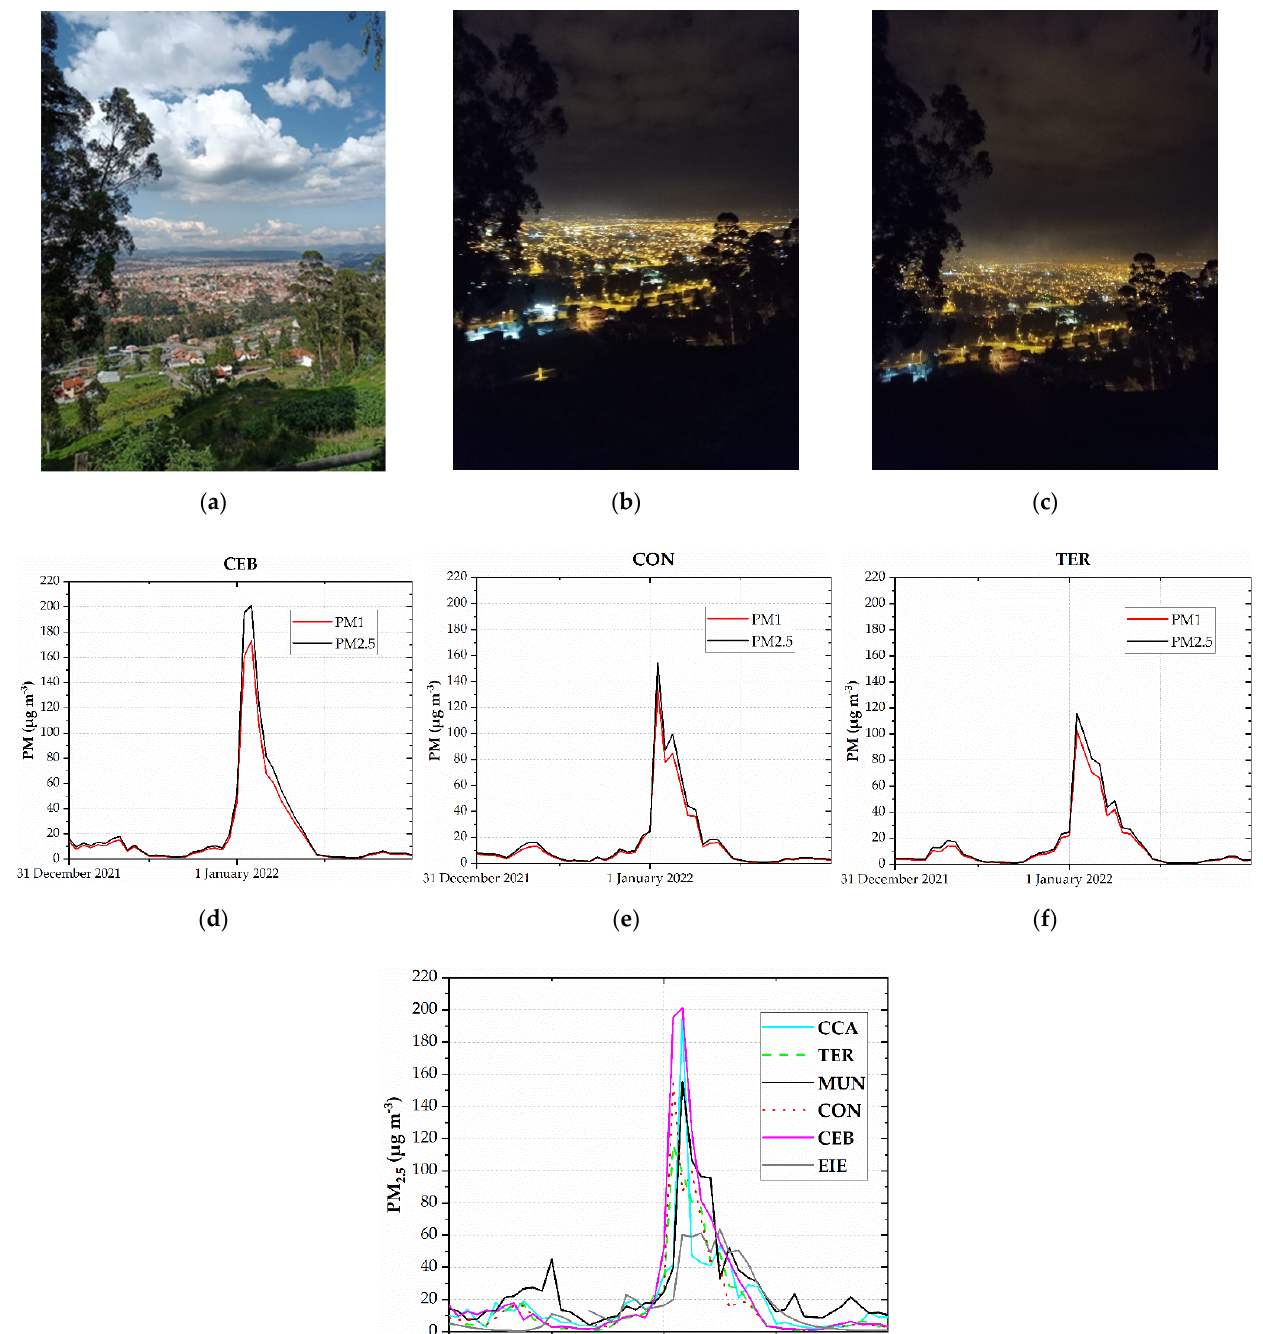
Figure 3. View of the city of Cuenca: ( a ) during the afternoon of 31 December 2021; ( b ) approximately 5 min before the midnight of 31 December 2021; ( c ) after the first 30 min of 1 January 2022. Hourly PM 1 and PM 2.5 concentrations on 31 December 2021 and 1 January 2022 measured at the CEB ( d ), CON ( e ), and TER ( f ) stations. ( g ) Hourly PM 2.5 concentrations on 31 December 2021 and 1 January 2022.